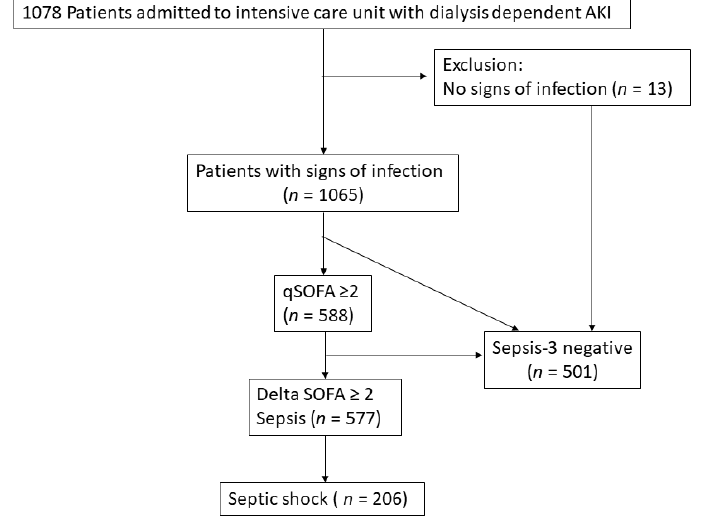
Figure 1. Algorithm of enrollee.